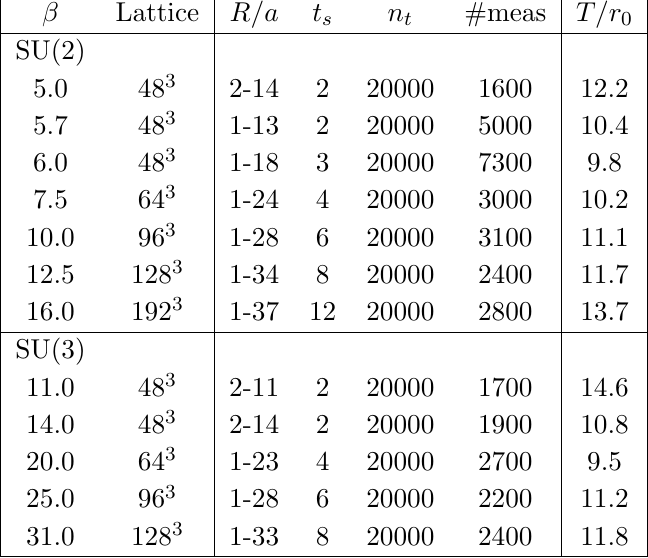
Table 2 . Simulation parameters for the extraction of the Polyakov loop correlation functions. Listed are the range of q (cid:22) q separations, the temporal extent of the LW sublattices t s , both in units of the lattice spacing, the number of sublattice updates n t and the number of measurements. We also list the temporal lattice extent in units of the Sommer scale r 0